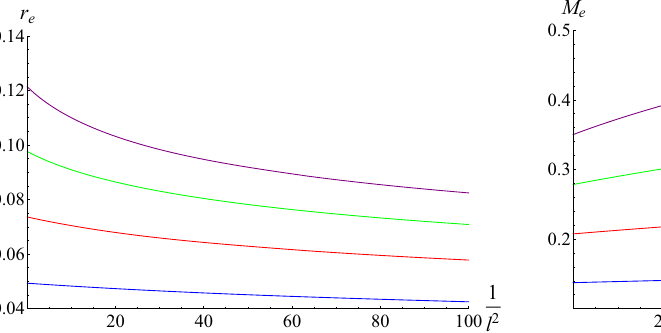
ics, at m 2 cc 1 = m 2 c 2 c 2 = 1. The blue, red, green and purple curves correspond to k = 0 . 1 , 0 . 15 , 0 . 2 , 0 . 25, respectively , for the different l 2